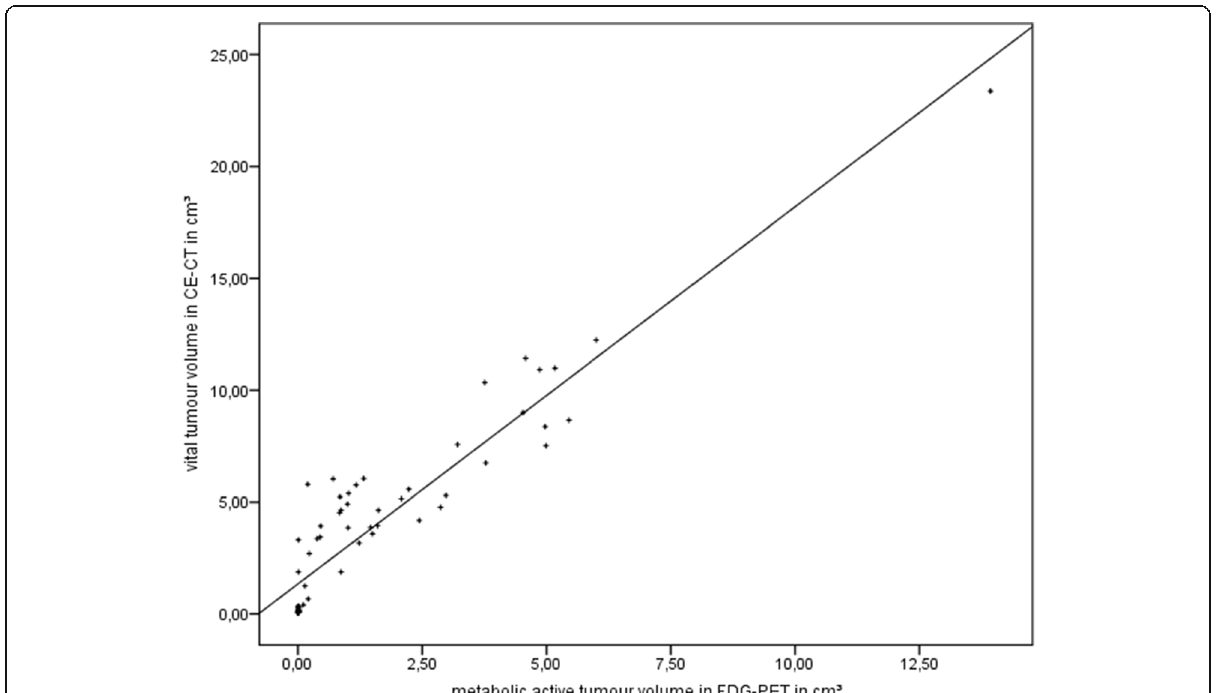
Fig. 10 Correlation. Spearman ’ s rank correlation between the metabolic active tumor volume in [18F]FDG-PET and the vital tumor volume in CE- CT; r = 0.919, p = 0.000